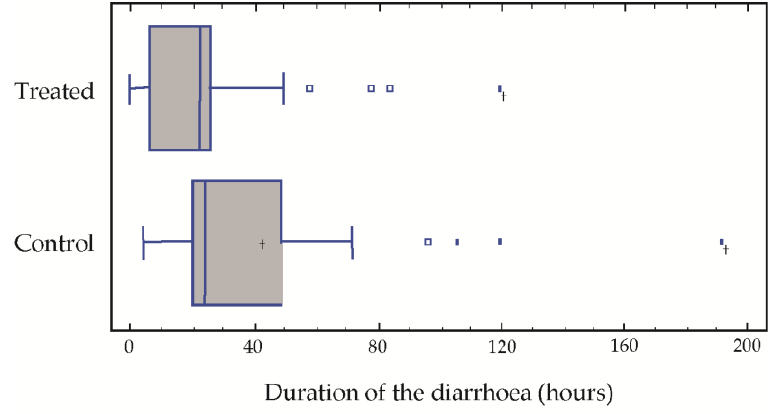
Figure 1. Duration of the diarrhoea for each sample group.